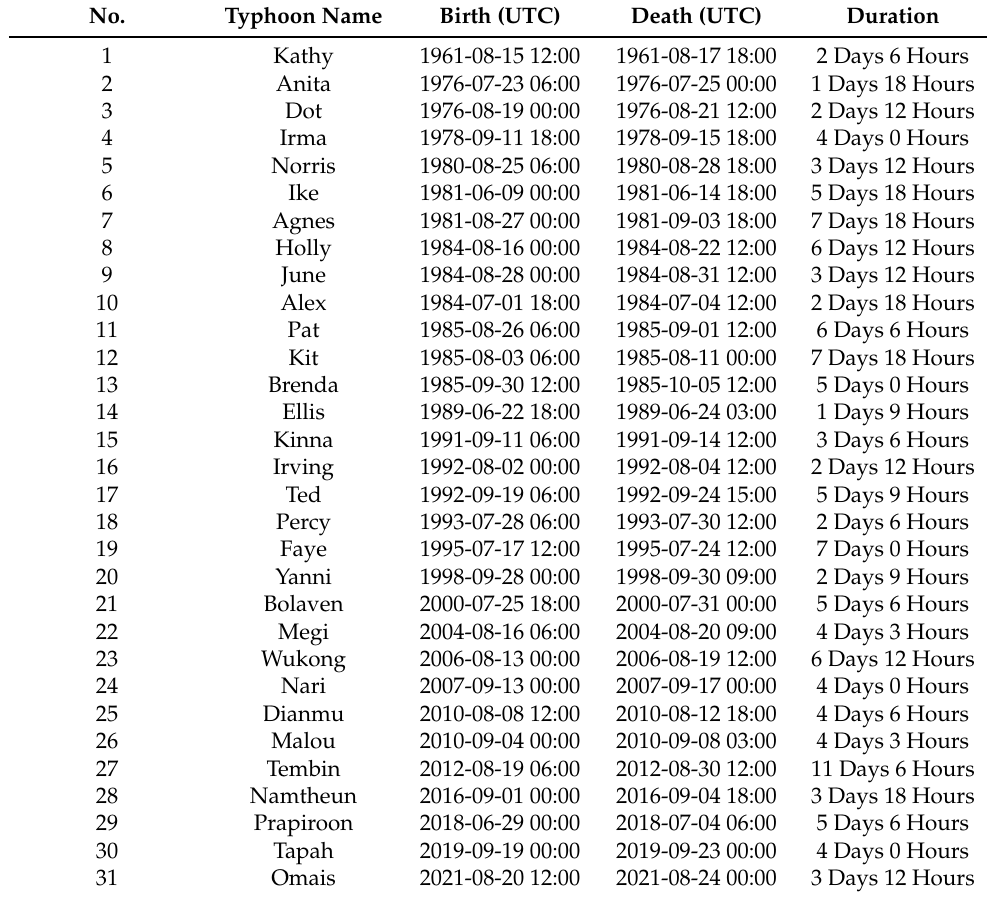
Table A2. Life data of past typhoons involved in the ensemble k-NN